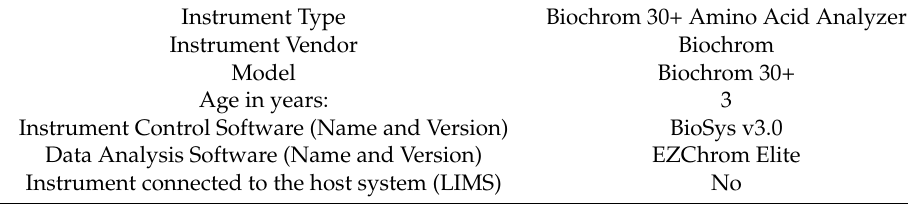
Table 1. Details of Biochrom 30+ amino acid analyzer physiological system.